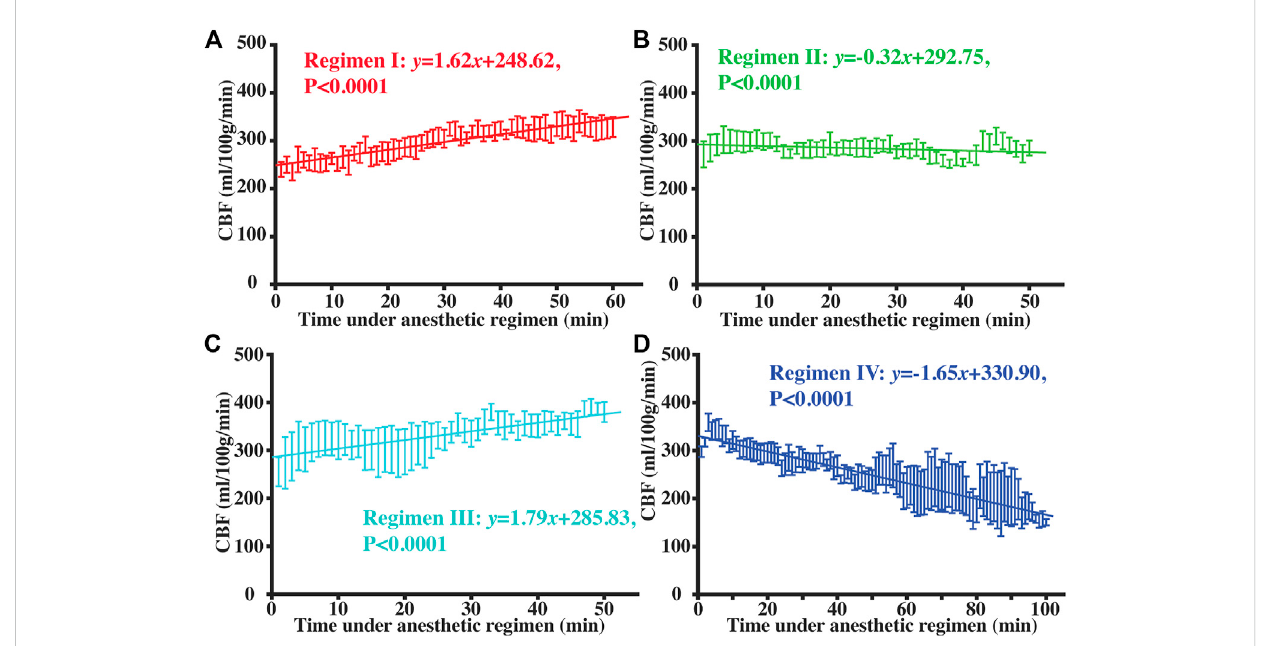
Scatter plots between iso fl urane dose and CBF (A) , RR (B) , and HR (C) . Red, green, cyan, and blue symbols corresponded to data collected under Regimens I, II, III, and IV, respectively. Solid lines denoted the fi tted equations with linear regression